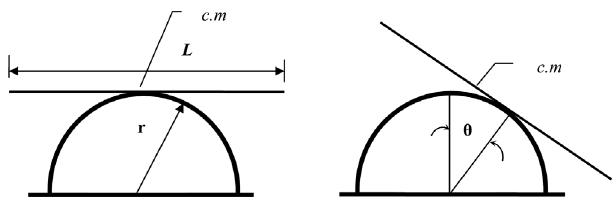
Fig. 1. Rigid rod rocks on a circular